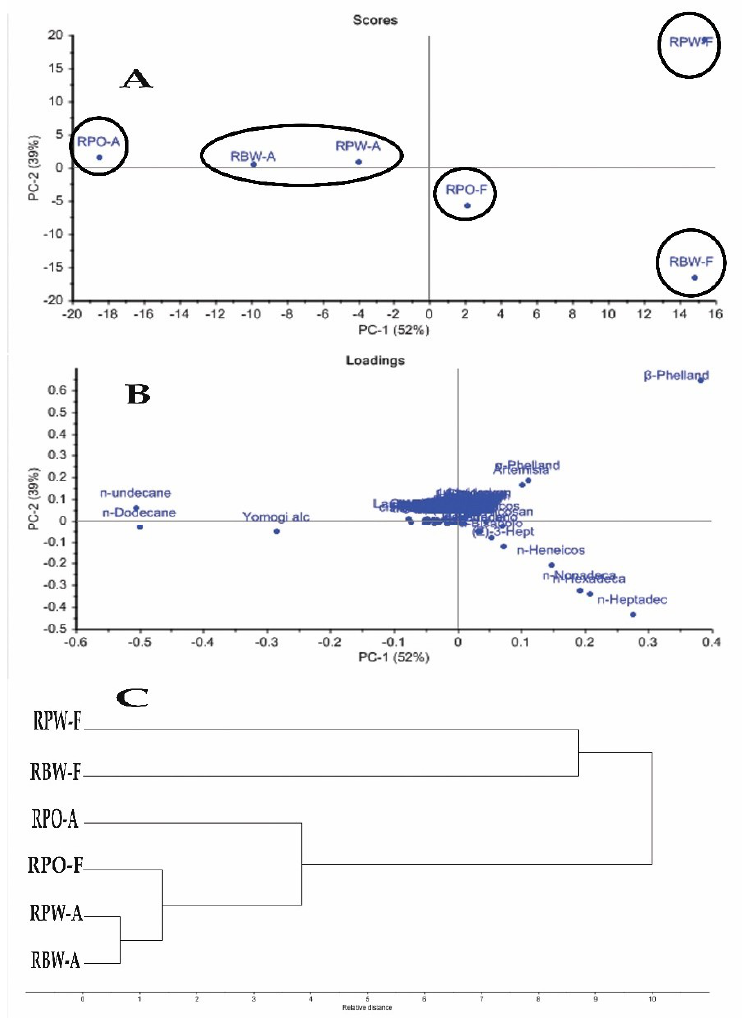
Figure 1. ( A ) Score plot of PC1 versus PC2 of the volatiles obtained from aerial parts and flowers of different Rosa varieties’ essential oils analyzed by GC/MS ( n = 6) (area % as a variable). ( B ) Loading plot for PC1 and PC2 contributing volatiles and their assignments (area % as variable). ( C ) Den- drogram illustrates the clustering of different aerial part and flower essential oils of different Rosa varieties (area %). [RBW ( Rosa banksiae var. banksiae Ait.), RPO ( Rosa polyantha Thunb. “orange fairy”), RPW ( Rosa polyantha Thunb. “white fairy”), A (aerial parts), F (Flowers)].